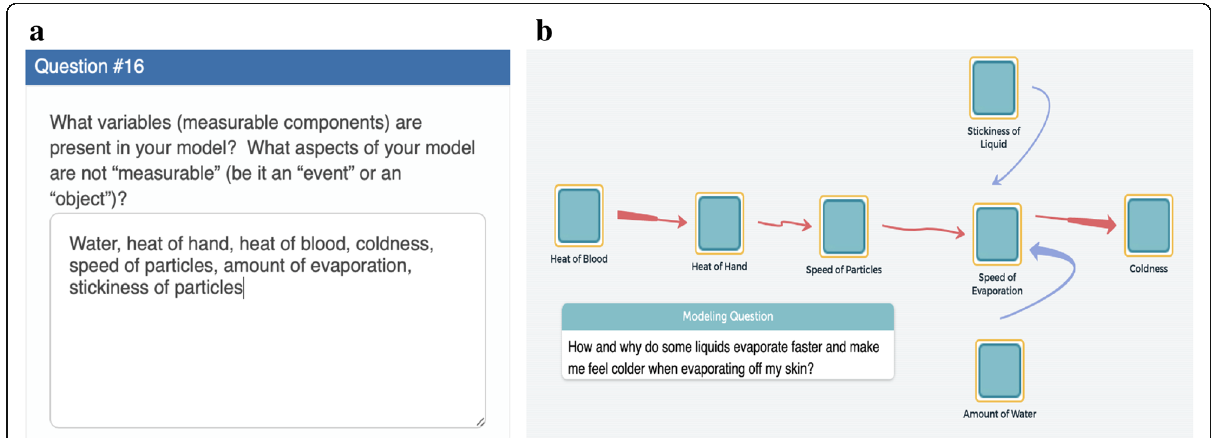
Fig. 6 Creating a computational model (artifacts) focusing on elements. a Student listing of variables. b Encode the variables in SageModeler